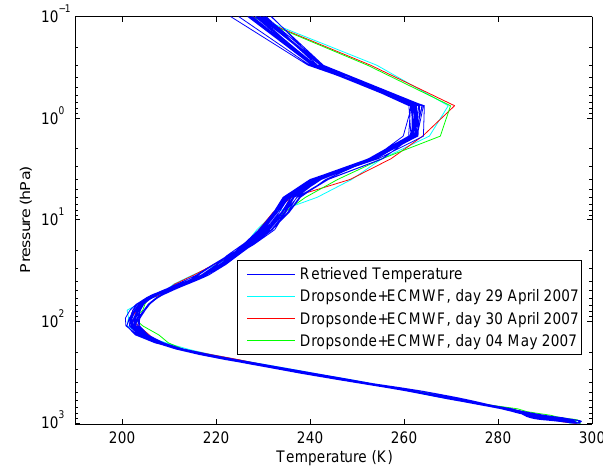
Fig. 13. The 25 IASI inverted temperature profiles compared to the observations (dropsonde/ECMWF). The dropsonde/ECMWF ob- servations are averaged to form one single profile for each day, which is shown in the